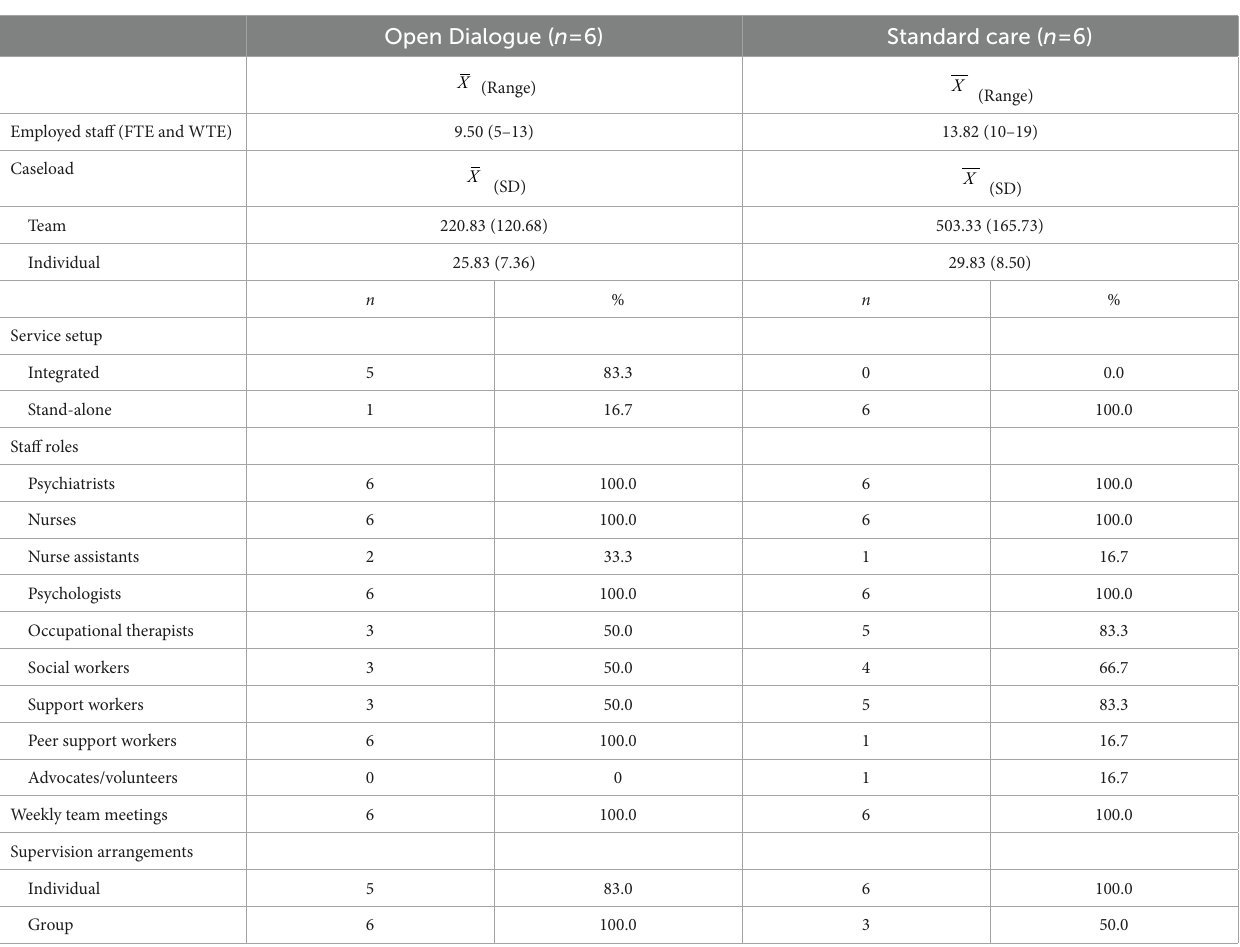
TABLE 1 Service